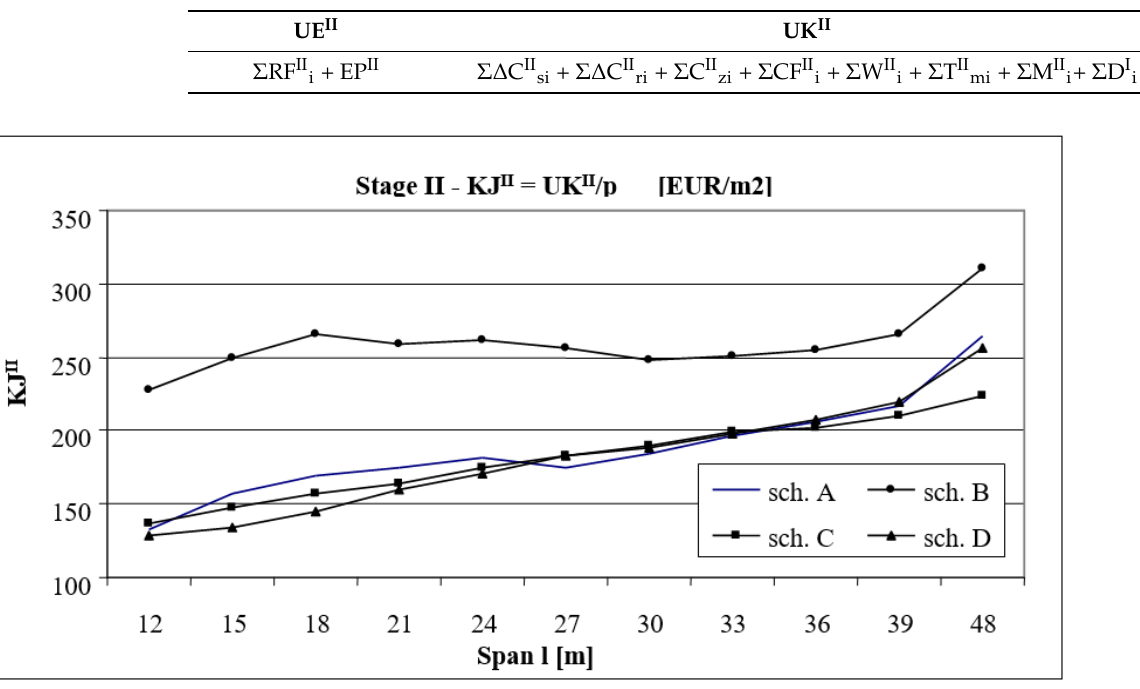
Figure 8. Generalized ecological indicator WE IIo —cycle II.